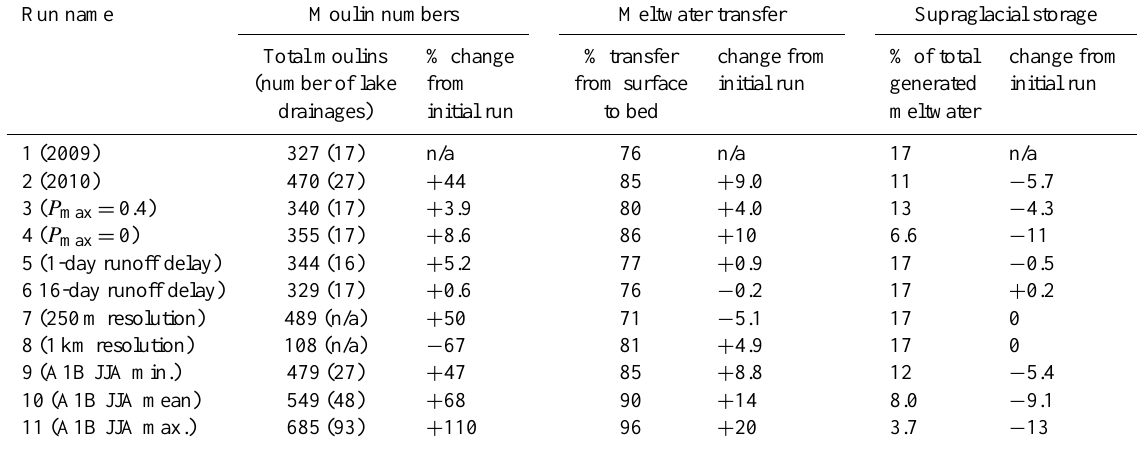
Table 1. Total number of surface-to-bed connections formed, the percentage of surface-generated meltwater delivered to the bed and the percentage of surface-generated meltwater stored supraglacially via refreezing and percolation in the snowpack for each model run. Meltwater not accounted for by transfer to the bed or supraglacial storage is stored englacially inside crevasses which have not reached the